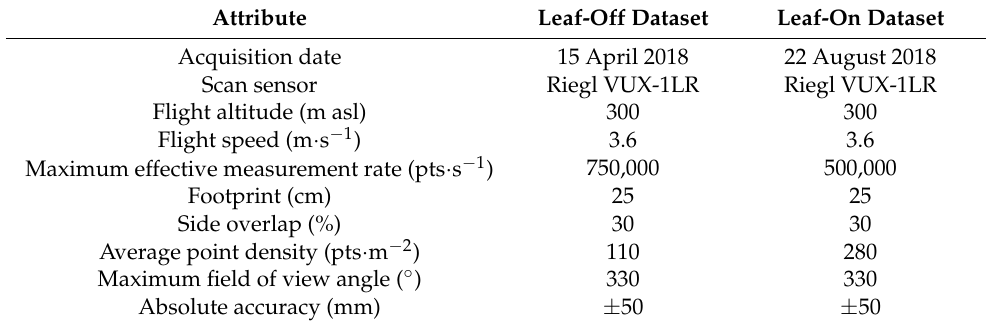
Table 2. LiDAR acquisition and sensor specifications from leaf-off and leaf-on datasets.